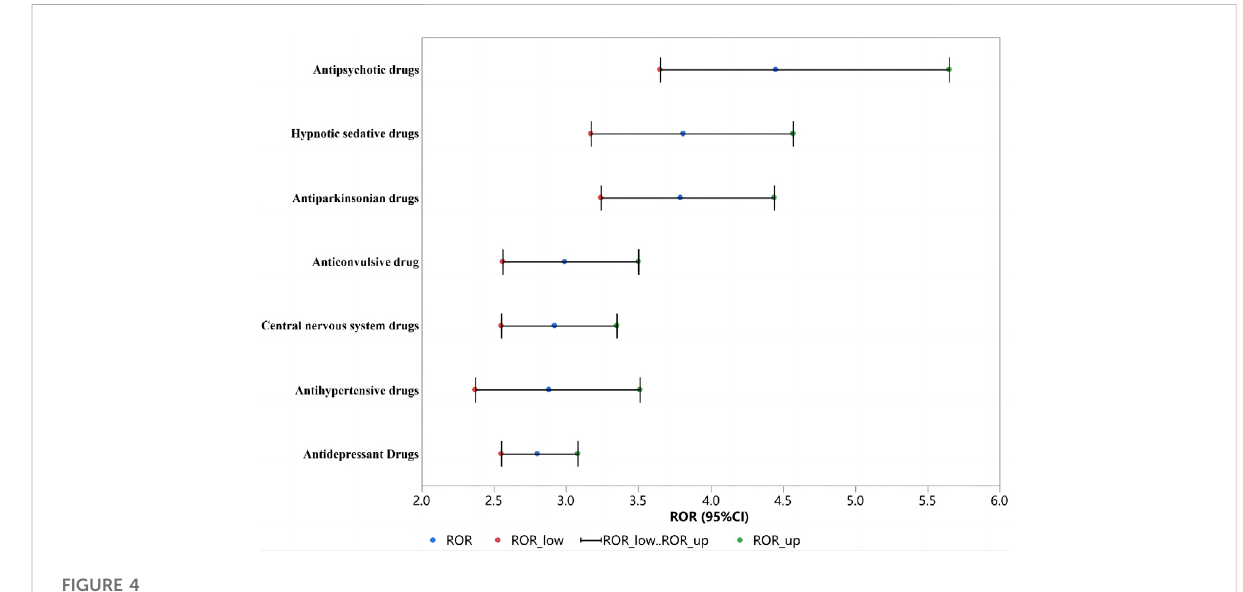
FIGURE 4 ROR for fall of each physiological system.